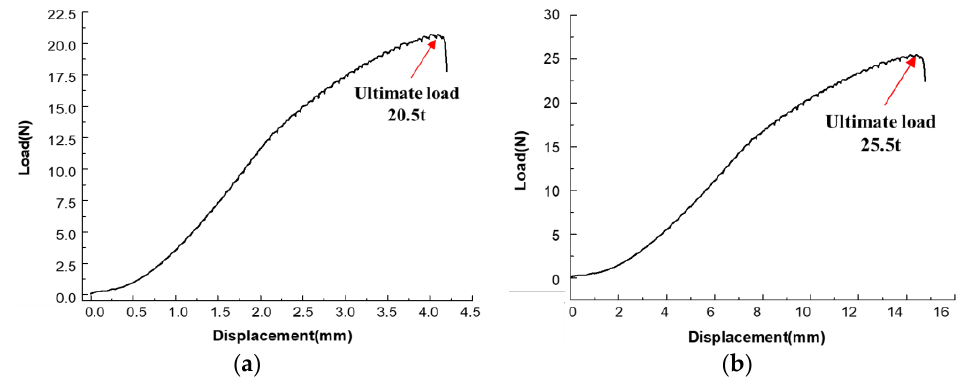
Figure 2. Tensile load-displacement curves of the specimens: ( a ) transverse welded specimen; ( b ) longitudinal welded specimen.